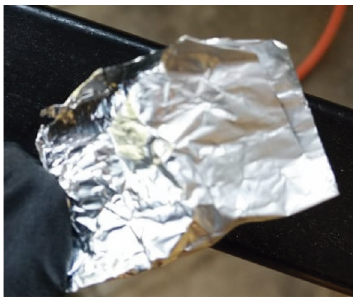
Figure 1. Al foil: etched (left) and non-etched (right)